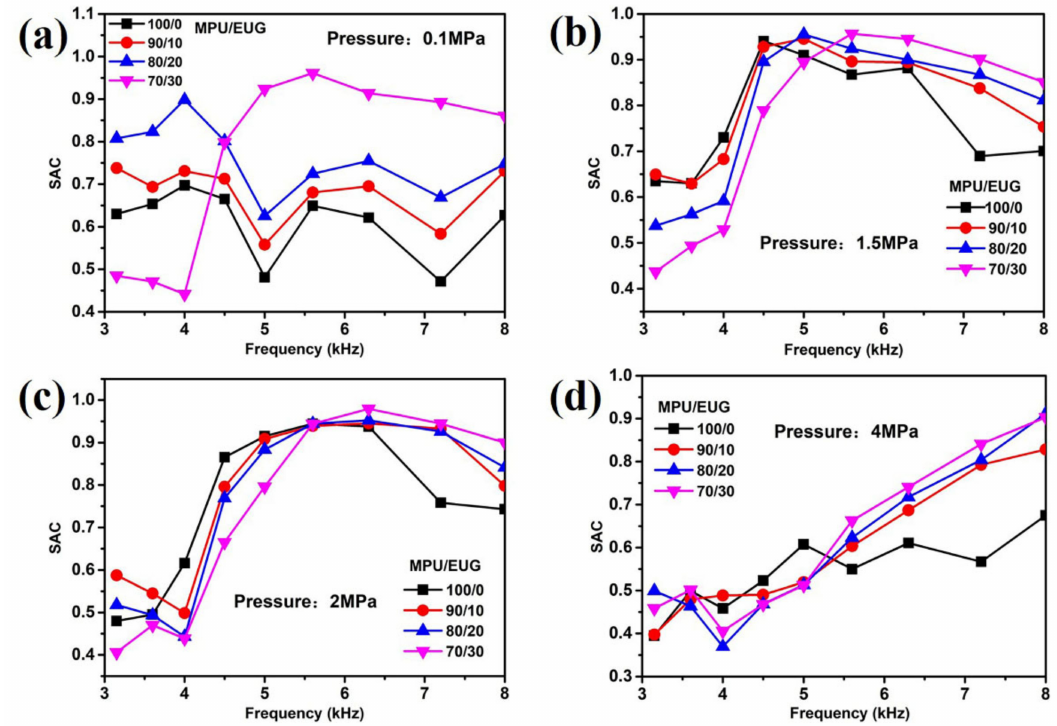
Figure 6. The sound absorption coefficient of various MPU/EUG composites under different pressures: ( a ) 0.1 MPa; ( b ) 1.5 MPa; ( c ) 2 MPa; ( d ) 4